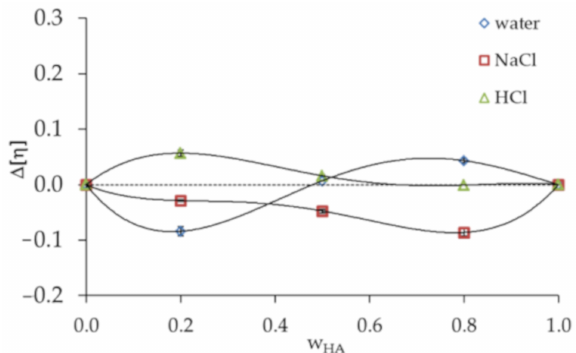
Figure 2. Plot of ∆ [ η ] criterion versus HA weight fraction ( w HA ) in HA / PVA blends in various